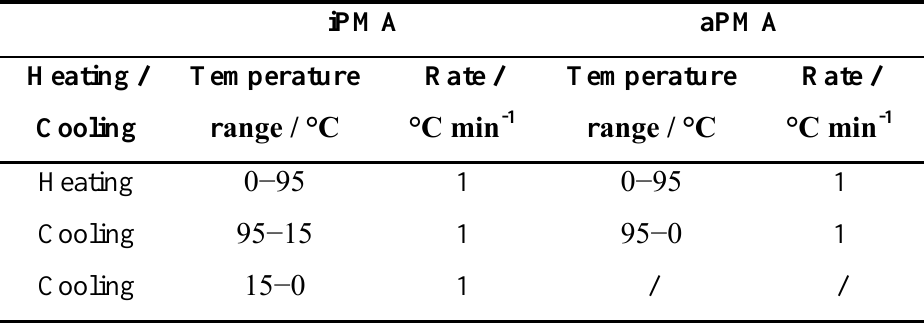
Table S5. Temperature program for heating and cooling of a- and iPMA